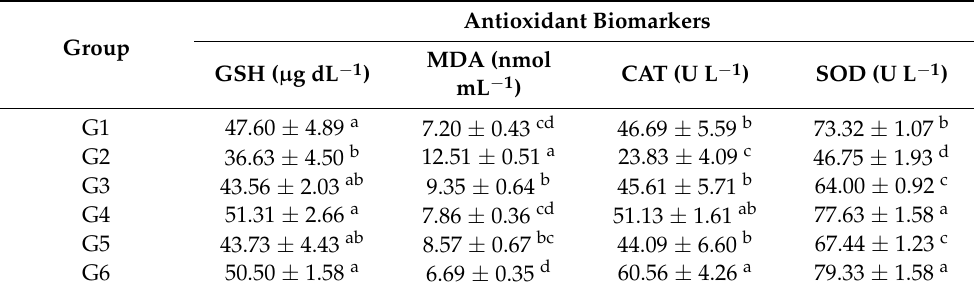
Table 7. The effects of FS and FSS extracts on antioxidant biomarkers in the blood serum of CCl 4 - induced nephrotoxicity and oxidative stress in rats (mean ± SE), n = 8.